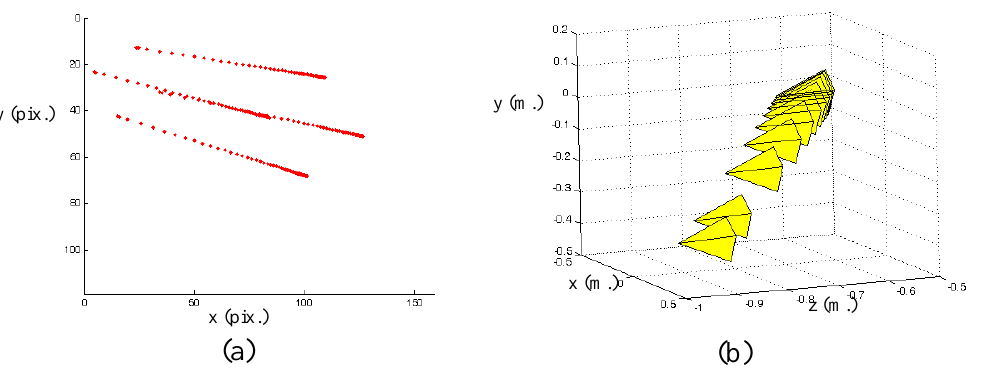
Figure 9. Trajectory during the visual servoing task. (a) Trajectory of the image features. (b) Trajectory of the eye-in-hand camera. Experiment 1.